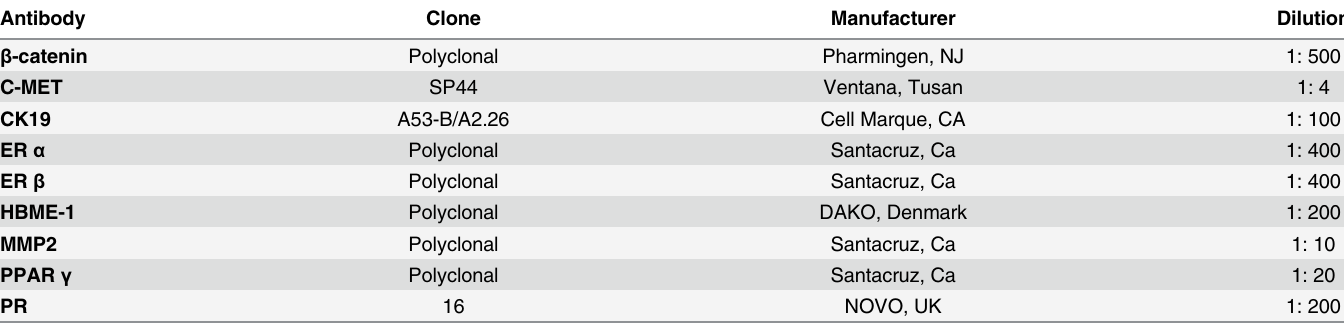
Table 1. Antibodies and conditions used in the